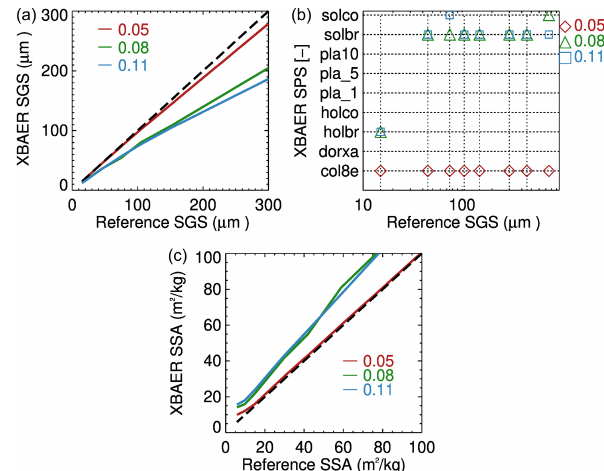
Figure 8. Impact of ice crystal surface roughness (ICSR) on the retrieval of SGS (a) , SPS (b) and SSA (c) . Different colors indicate different ICSRs used in the retrieval.